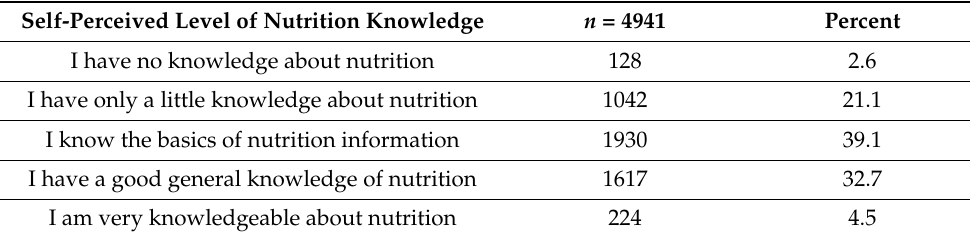
Table 2. Self-perceived level of participant nutrition knowledge before commencing the MOOC.